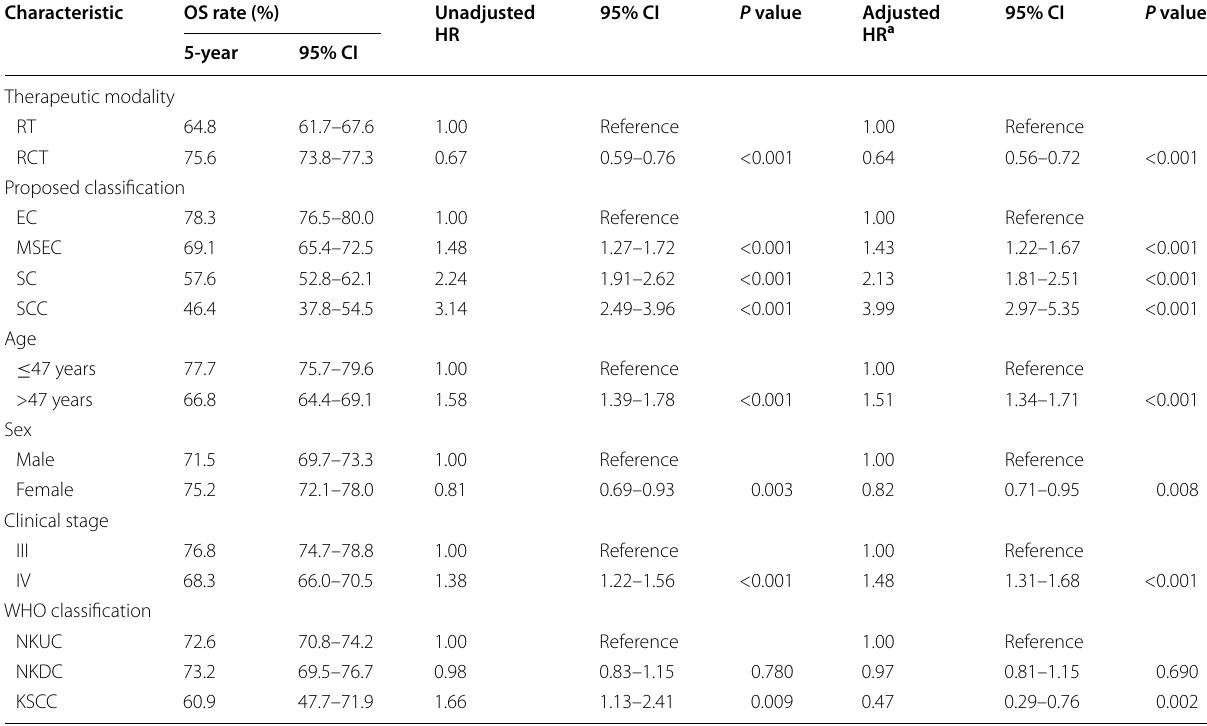
Table 6 Cox proportional regression analysis of associations between clinical characteristics and OS in 3893 patients with advanced